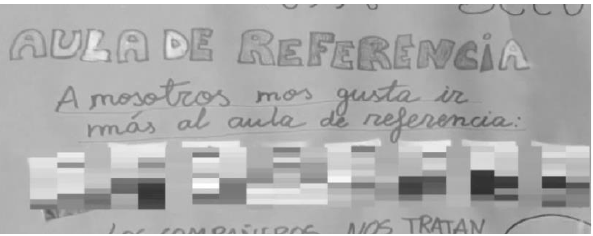
Figure 1. In this quotation graphic, the students of a secondary SOC affirm that they would like to attend the reference classroom more often alongside the rest of their classmates.